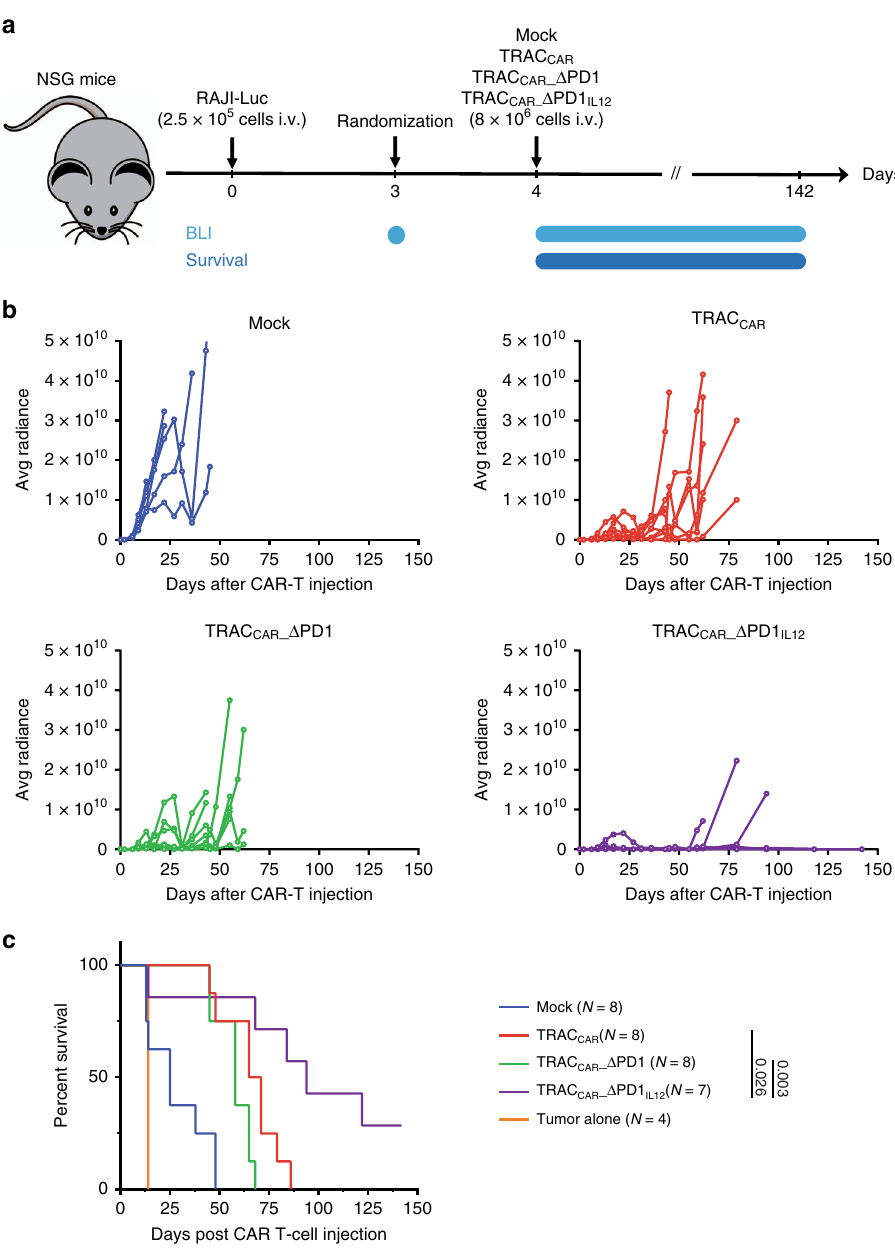
Fig. 8 Conditional secretion of IL-12P70 increases antitumor activity of TRAC CAR T cells in vivo. a Schematic showing the experimental design to investigate the antitumor activity of engineered TRAC CAR T cells in xenograft mice model. Immunode fi cient NSG mice were adoptively transferred on day 0 with RAJI-Luc-GFP tumor cells (2.5 × 10 5 cells per animal in 100 μ L of PBS i.v.). Tumor cells were allowed to expand until mice randomization, performed at day 3 on the basis of the level of tumor cell bioluminescence signal. On the same day, mice were adoptively transferred (i.v.) with 7 × 10 6 viable mock- transduced T cells, TRAC CAR T cells ( n = 8), TRAC CAR _ Δ PD1 ( n = 8), TRAC CAR _ Δ PD1 IL12 ( n = 7) T cells or tumor alone ( n = 4). RAJI-Luc-GFP tumor